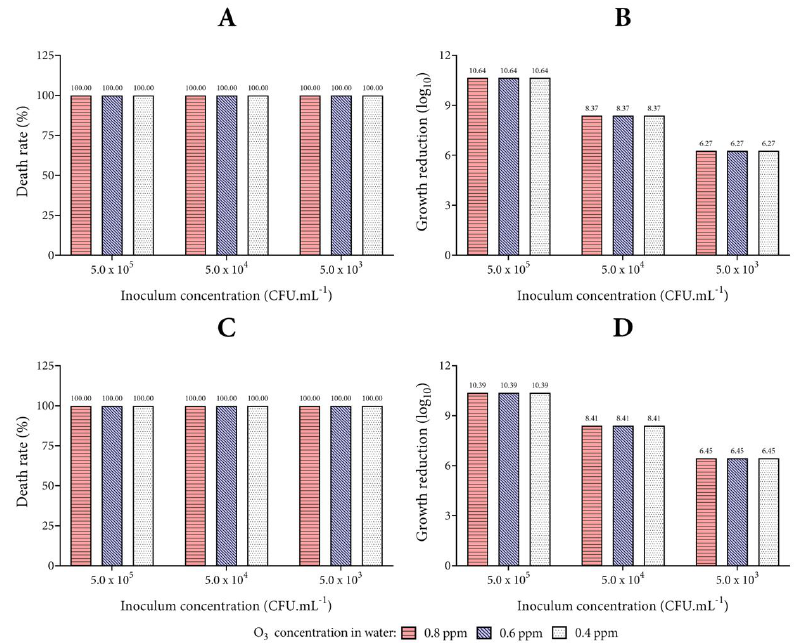
Figure 6. Action of ozonized water on Gram-positive bacteria. Analysis of the percentage of death and growth reduction in Log 10 for the microorganisms S. aureus ( A , B ) and E. faecalis ( C , D ). The concentrations of 0.8, 0.6, and 0.4 ppm of O 3 dissolved in tap water were tested, and the number of colonies on each agar plate was calculated after incubation (1.0 mL of inoculum and 4.0 mL of ozonized water at 20 °C for 1 min).